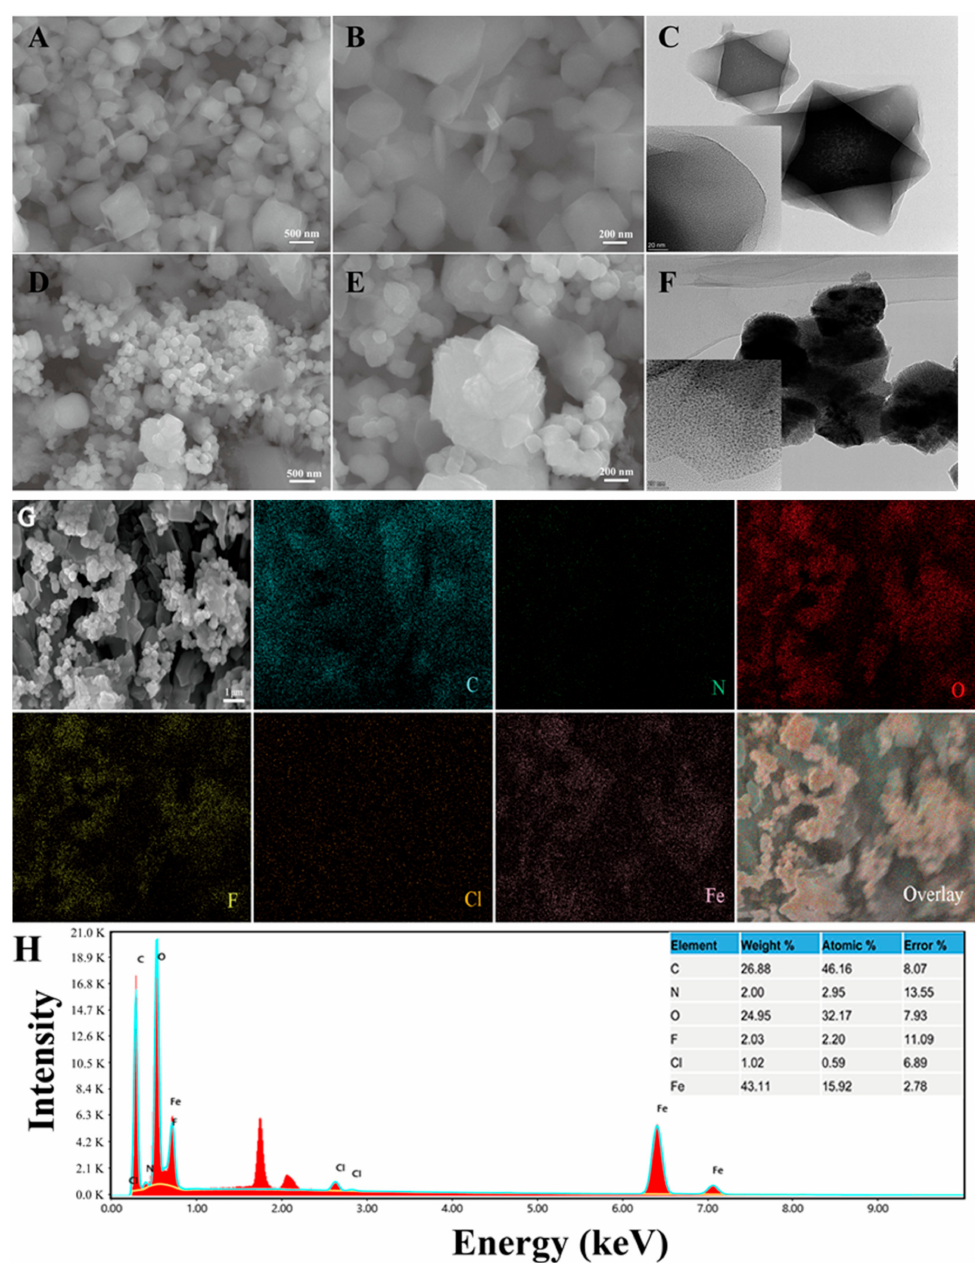
Figure 4. Scanning electron microscopy (SEM) ( A , B ) images of MIL-101(Fe) and MIL-101(Fe)-T705 ( D , E ). Transmission electron microscopy (TEM) ( C ) images of MIL-101(Fe) and MIL-101(Fe)-T705 ( F ). ( G ) SEM image and energy-dispersive X-ray spectroscopy (EDS) for elemental color mappings (C, N, O, F, Cl, Fe) and ( H ) the EDS spectrum of the